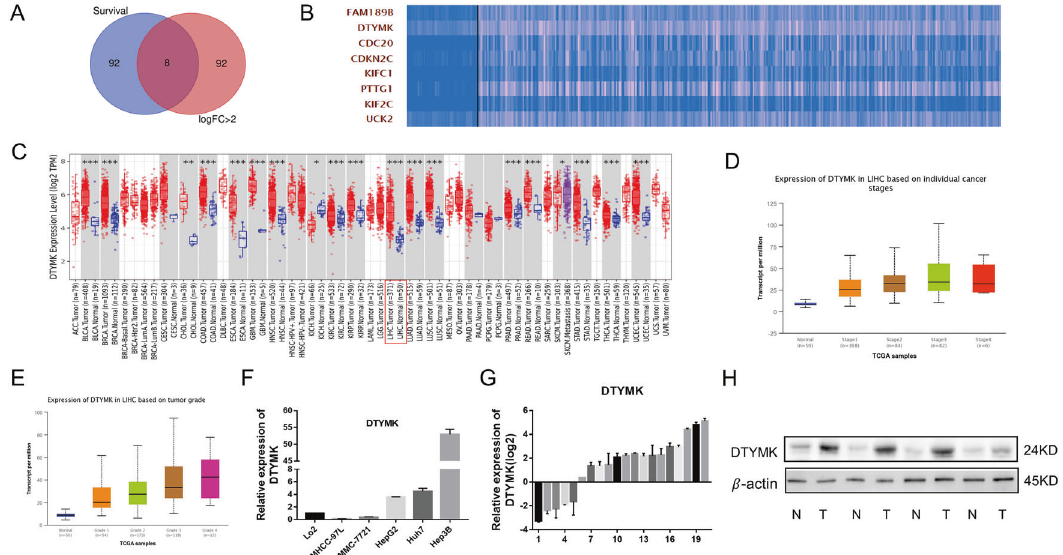
Fig. 1 Increased expression of DTYMK in HCC. A Gene analysis of patients with HCC from TCGA. B Eight genes were upregulated and had the most signi fi cant survival differences ( C ) DTYMK expression increased in multiple cancer types, especially in HCC. D Expression of DTYMK was related to cancer stages. E Expression of DTYMK was related to cancer grades. F Increased RNA level of DTYMK in HepG2, Huh7, and Hep3B HCC cell lines. G Increased RNA level of DTYMK in most patients with HCC. H Increased protein level of DTYMK in most patients with